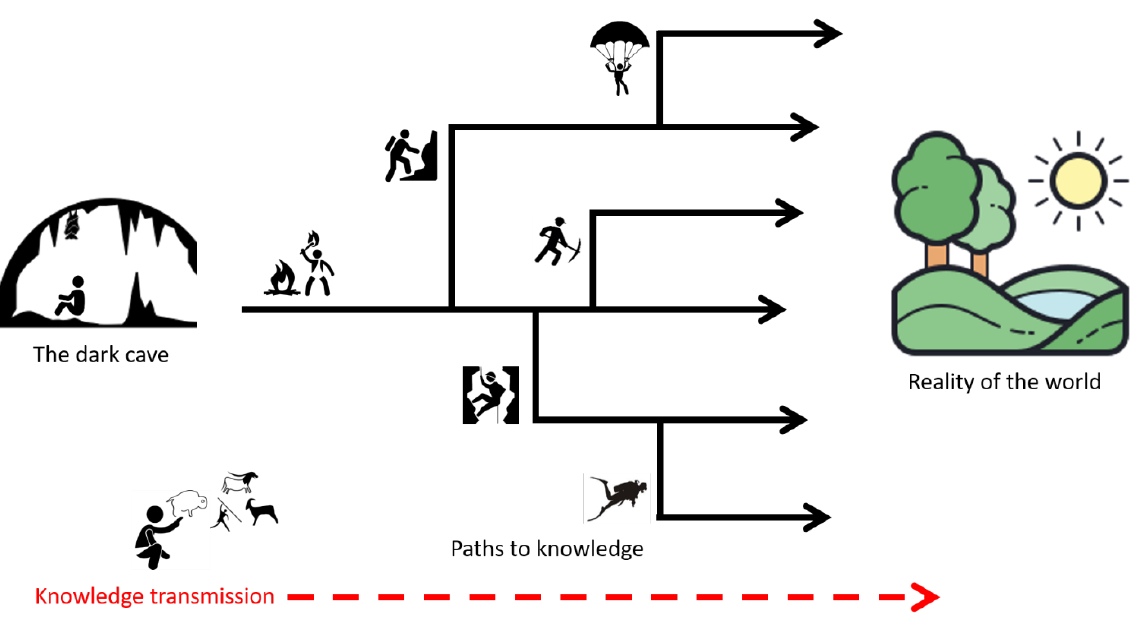
Figure 1. Paths of knowledge acquisition with reference to Plato’s Allegory of the Cave. Men are initially locked in a dark cave (left) away from the light of knowledge. Knowledge acquisitions (e.g. the discovery of fire) through generations open new paths (center) towards the reality of the world (right), each path opening possibilities for deeper levels of knowledge acquisition. Knowledge transmission (red) is key to progressing through these often arduous and interdependent